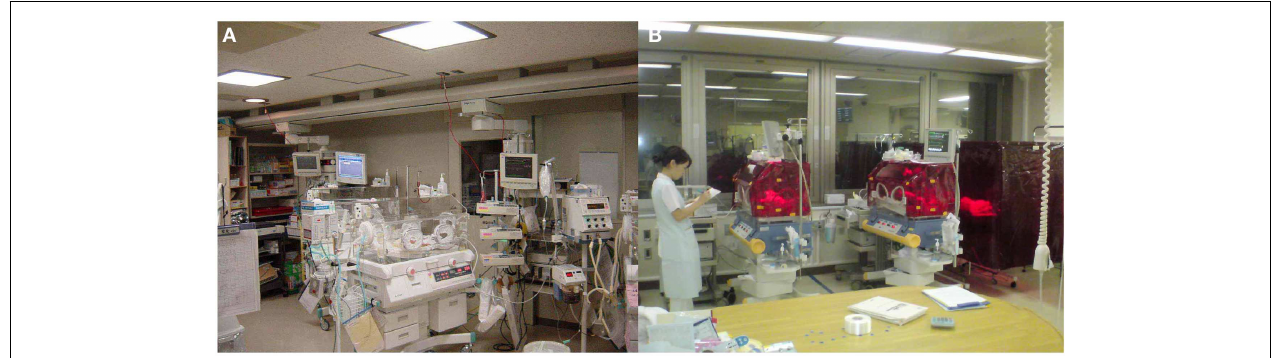
The background lighting was generally between 50 and 600lux. (B) Artificial night in the experimental group was achieved by covering the isolettes or cribs with a light filter from 20:00 to 5:30. From 5:30 to 20:00, the light filter was removed from the isolette.